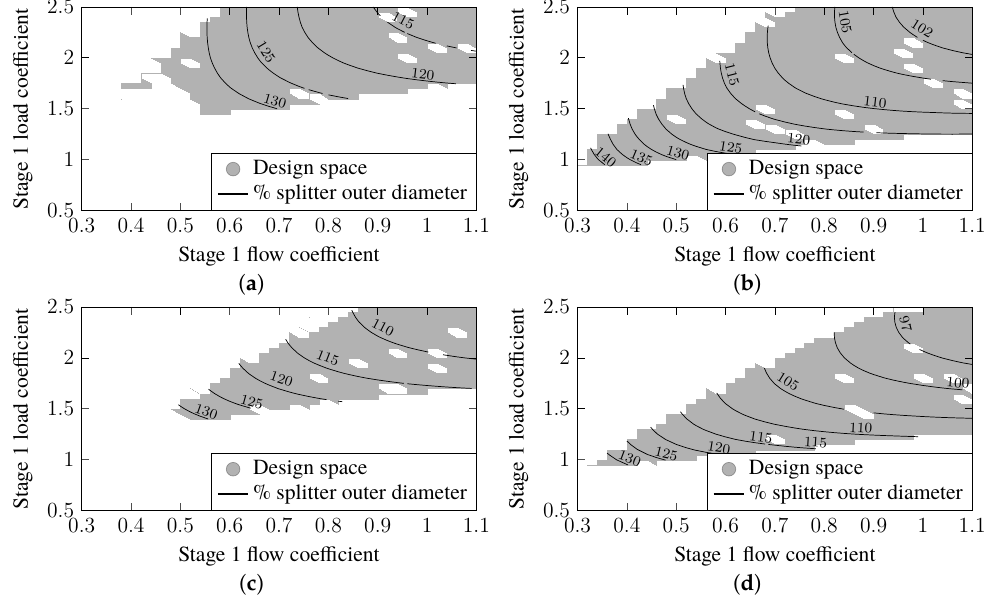
Figure 17. Comparison of the dimensions of low-pressure turbine design maps: ( a ) constant hub, two stages; ( b ) constant hub, three stages; ( c ) constant mean, two stages; ( d ) constant mean, three stages. If a certain critical value for the exit axial Mach number is mandatory, it can serve as an additional design limit. This would impose a boundary to the right side of the depicted design spaces. An observed maximum of Ma 0.5 was provided in [49]. In any case, an axial discharge flow is desirable. Any deviation from the axial direction has to be compensated in the subsequent turbine exit